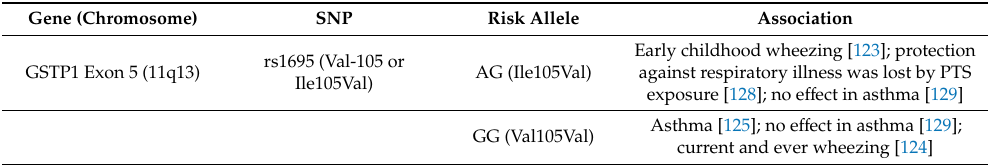
Summary of addressed single nucleotide polymorphisms (SNPs) regarding genetic predisposition to tobacco smoke